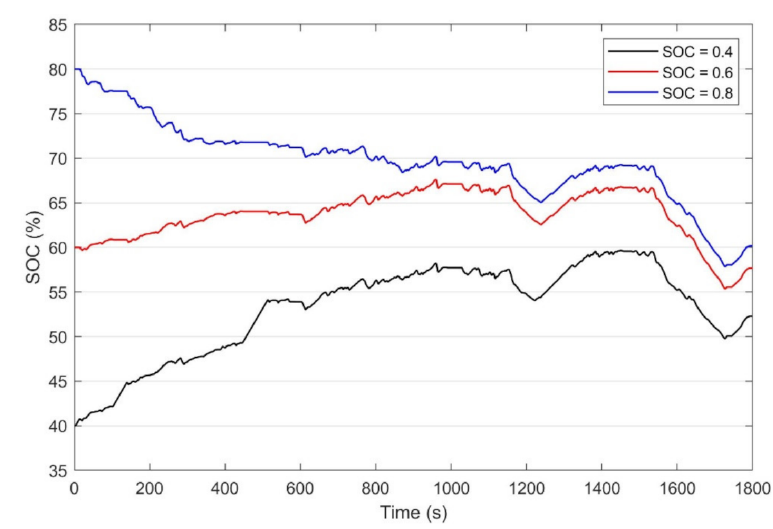
Figure 19. Variation in SOC under different values. Compared with the rule-based and the DP-based strategies, the equivalent 100 km hydrogen consumption of the improved rule-based strategy under different initial SOC values is significantly reduced, as shown in Figure 20. Under different initial SOC values, the equivalent 100 km hydrogen consumption in the improved rule-based strategy is reduced by 5.31%, 6.46% and